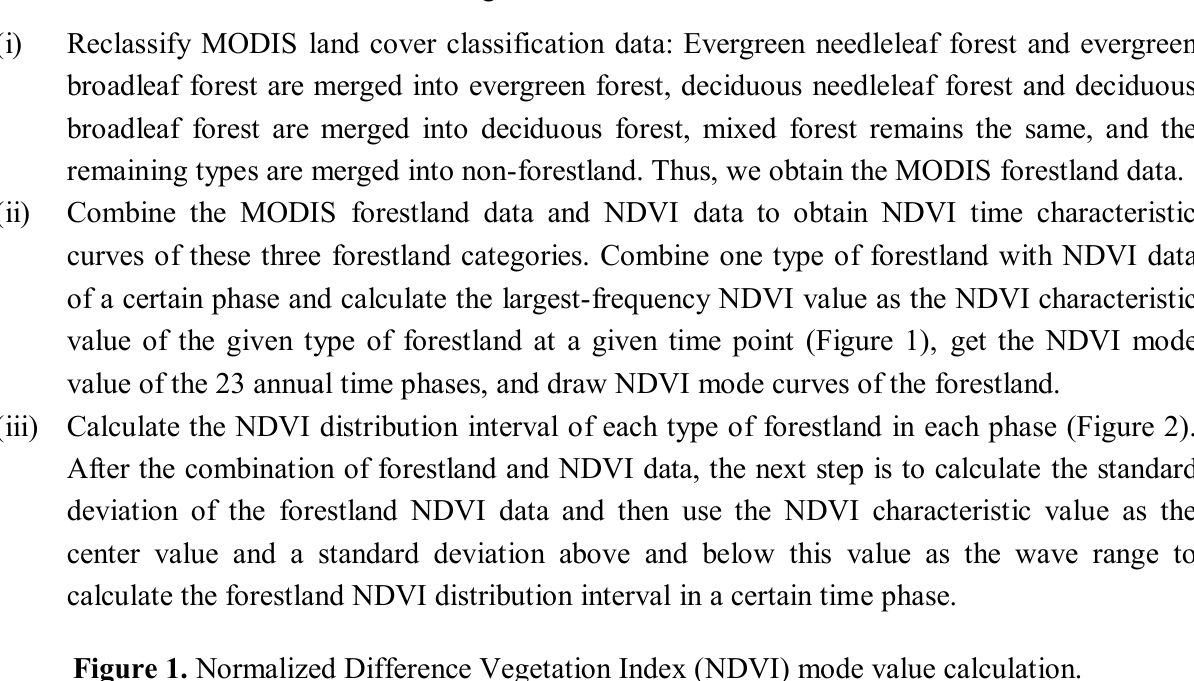
Figure 1. Normalized Difference Vegetation Index (NDVI) mode value calculation.